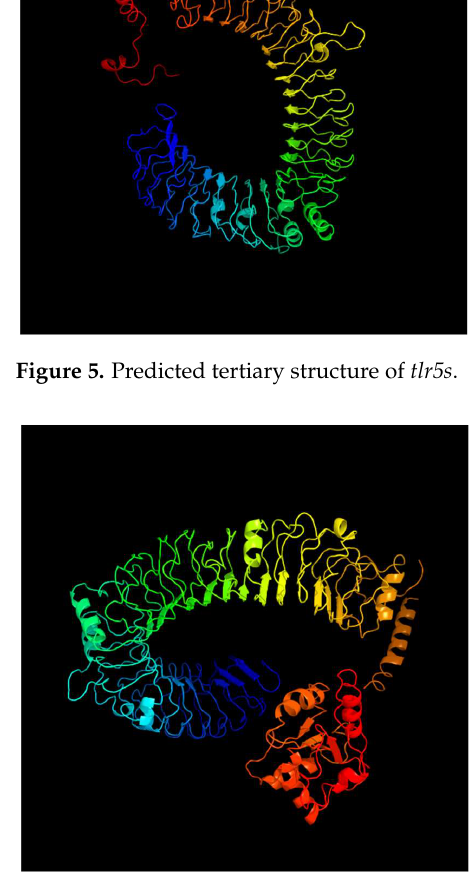
Figure 6. Predicted tertiary structure of tlr5m .